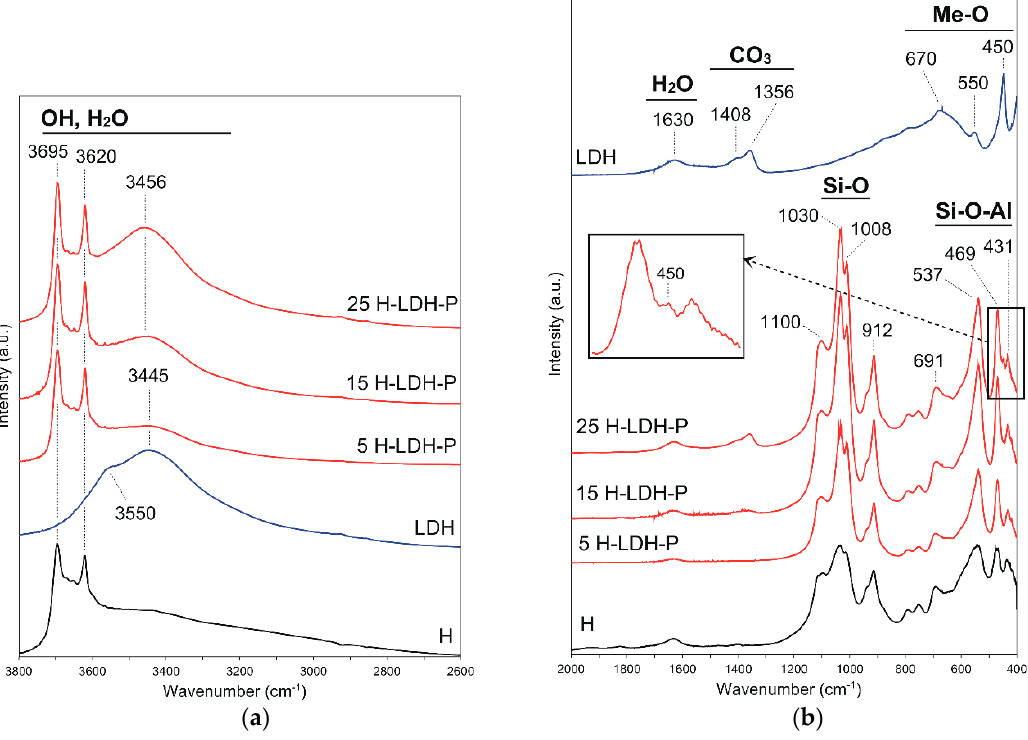
Figure 2. FTIR spectra of halloysite sample H, LDH and H-LDH-P materials in the ( a ) 3800–2600 cm − 1 range and ( b ) 2000–400 cm − 1 range.